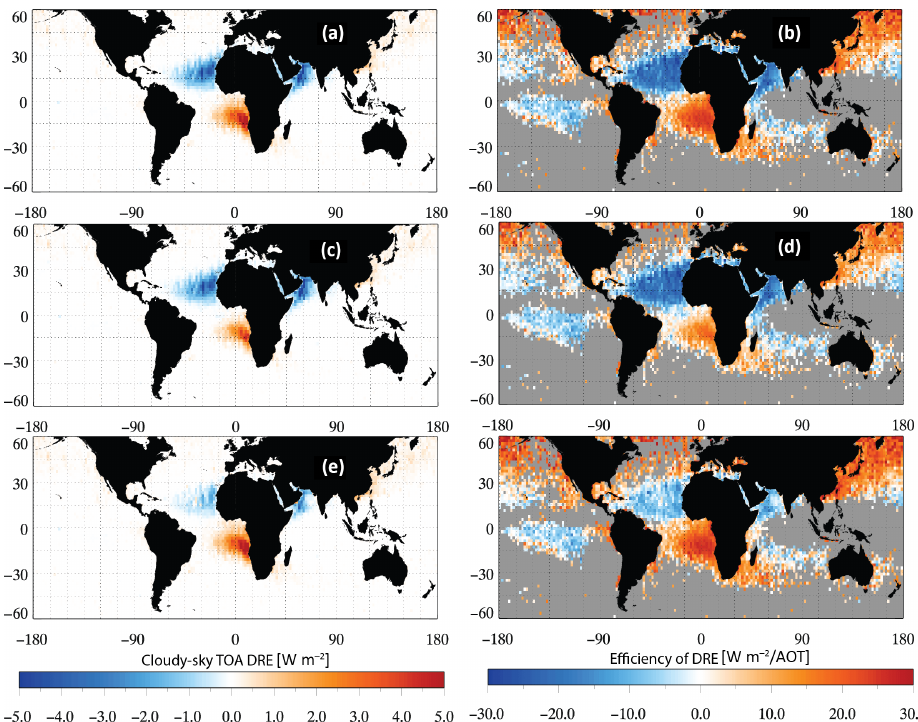
Figure 16. Same as Fig. 14, except that the scaled AOT based on Eq. (11) is used in the computations for smoke aerosols.